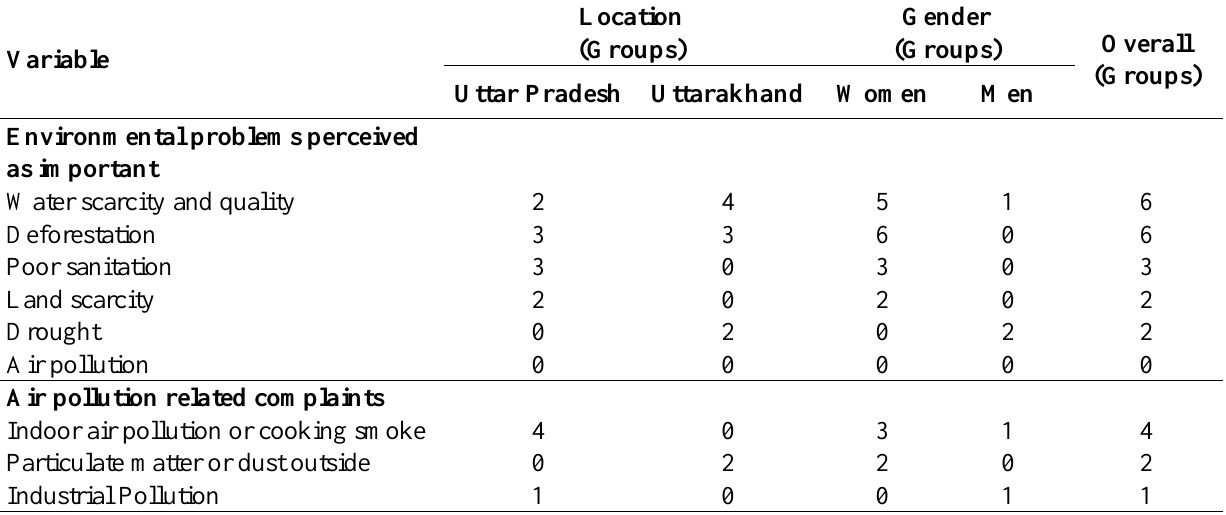
Table 3. Descriptive Statistics (Group questions; n =